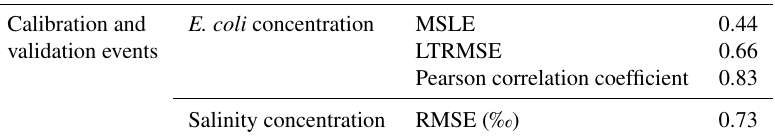
Table 3. Model performance parameters.